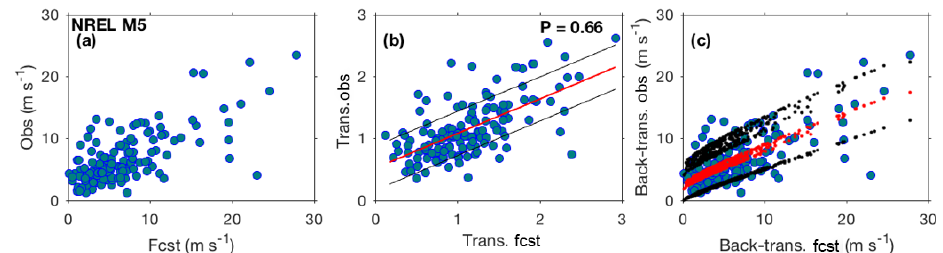
Figure 3. Scatterplots of (a) observations (obs) versus forecasts (fcst), (b) unit-less transformed observations versus transformed forecasts, and (c) the back-transformation of the observations versus the back-transformed forecasts from the NREL M5 tower at an 00:00UTC initialization and a 2h forecast lead time. The exponent P used in the power transformation is shown in (b) . The least-squares linear regression trends (solid red line in b and red dots in c ) and lines representing 1 standard deviation (solid black line in b and black dots in c ) from the regression lines are displayed for the transformed and back-transformed